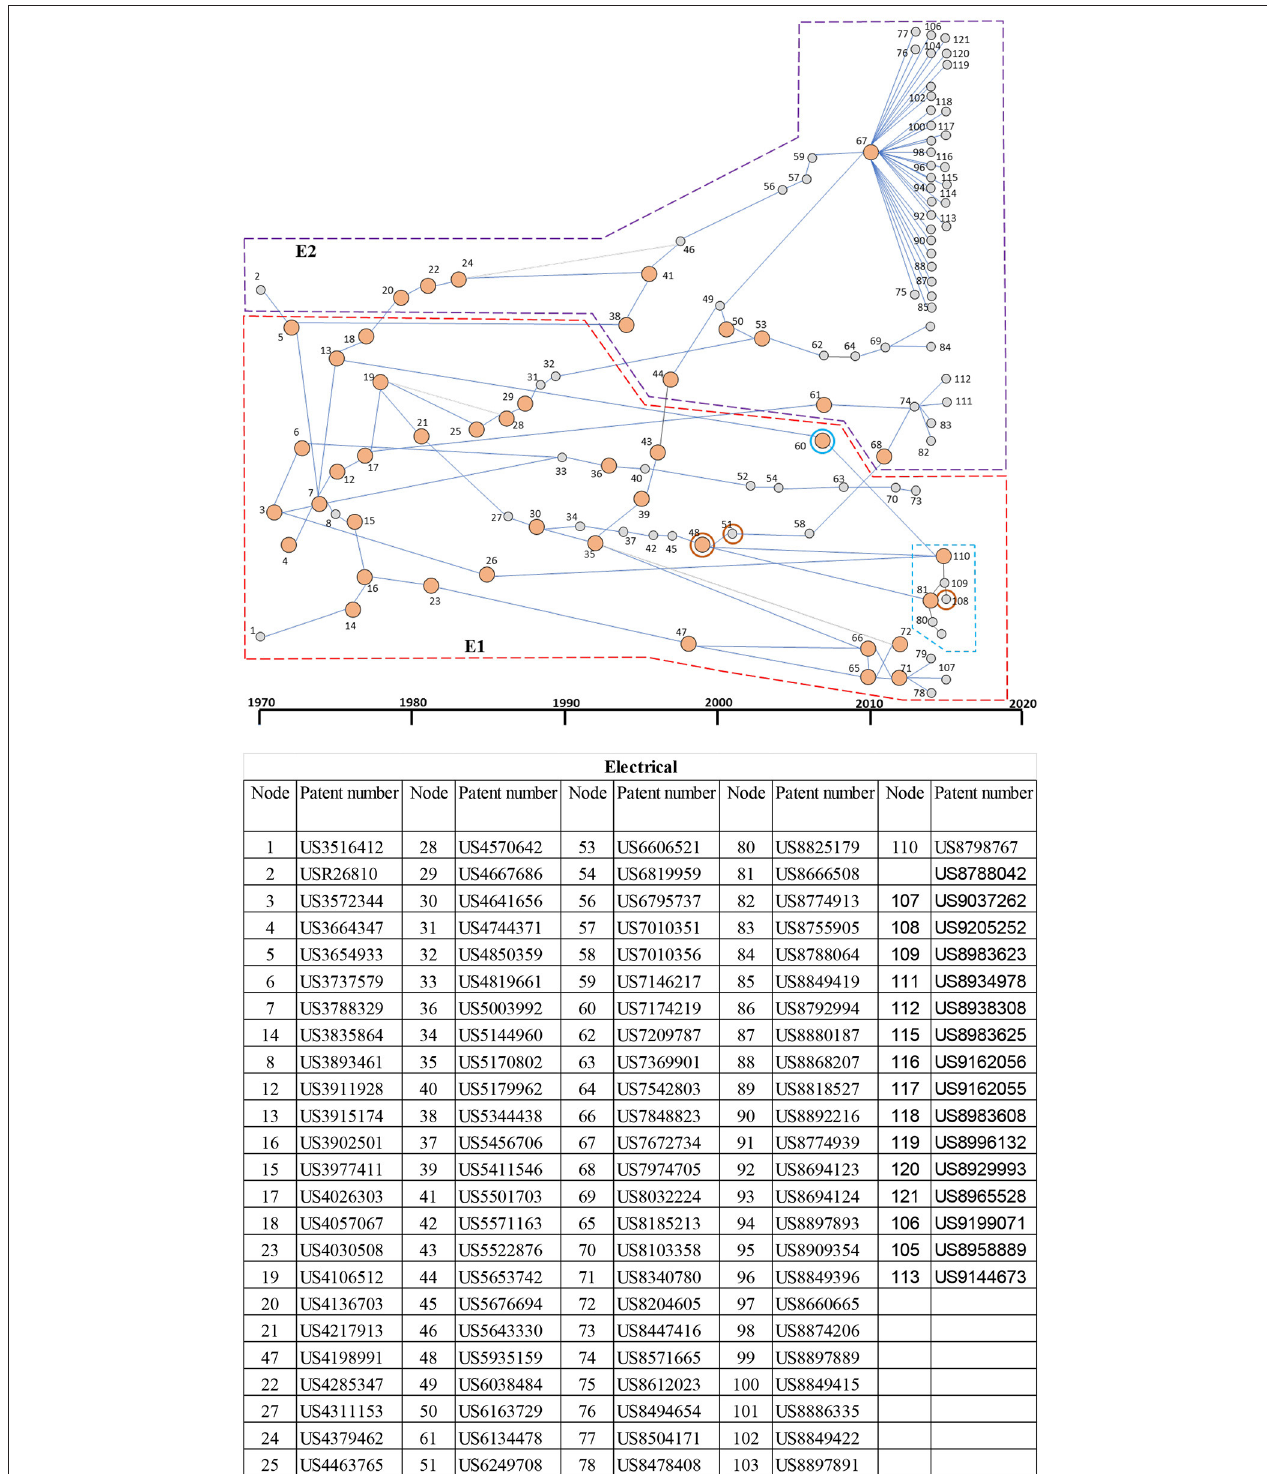
FIGURE 6 | Main paths for the electrical therapeutic domain. E1: A patent cluster for cardiac stimulation for pacing and defibrillation (red box); E2: A patent cluster for neurostimulation (purple box). The blue box shows a subcluster for MRI-compatible leads and electrodes. The patents inside the E1, which are highlighted with red concentric circles, are neuromodulation patents. The table presents details of each patent in the main paths. High-persistence patents are shown as bigger yellow circles, whereas the low-persistence patents are shown as smaller gray circles.